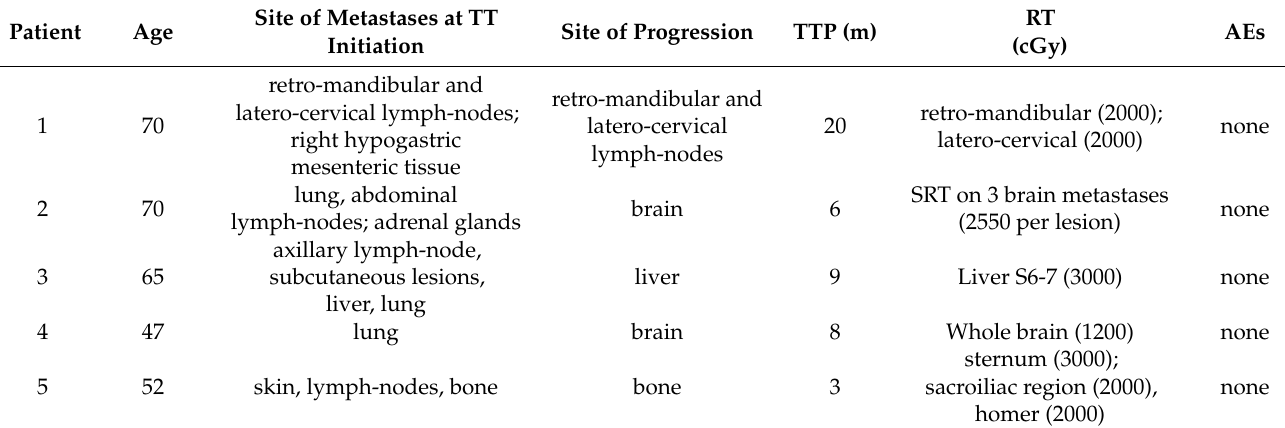
Table 1. Patients treated with RT and TT beyond